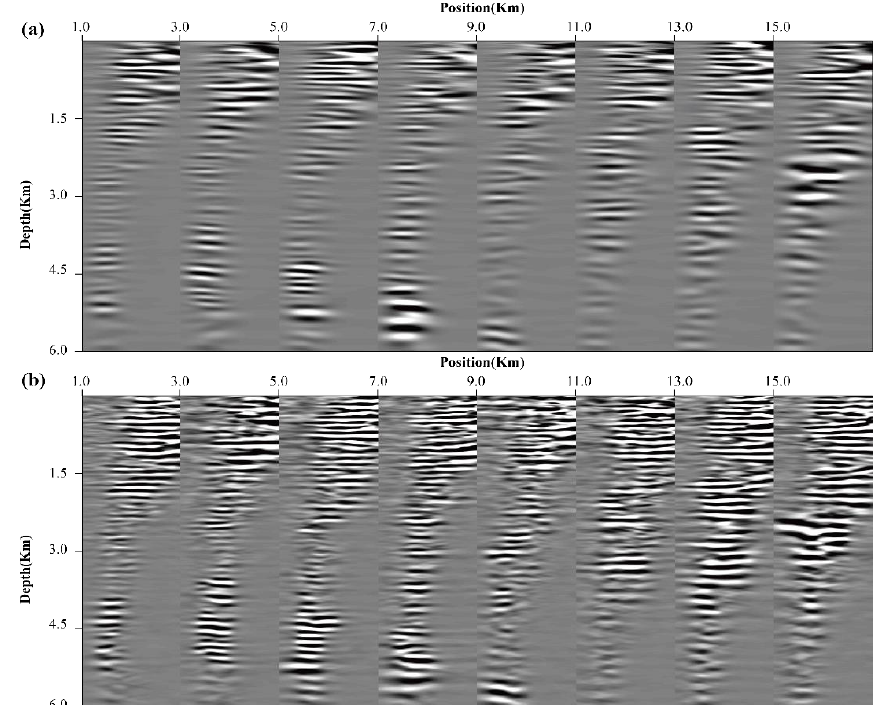
Figure 12. Angle gathers obtained with ( a ) Method 1 and ( b ) Method 4. The reflection angle range is [0°, 50°]. All images are regularized to the same amplitude scale.